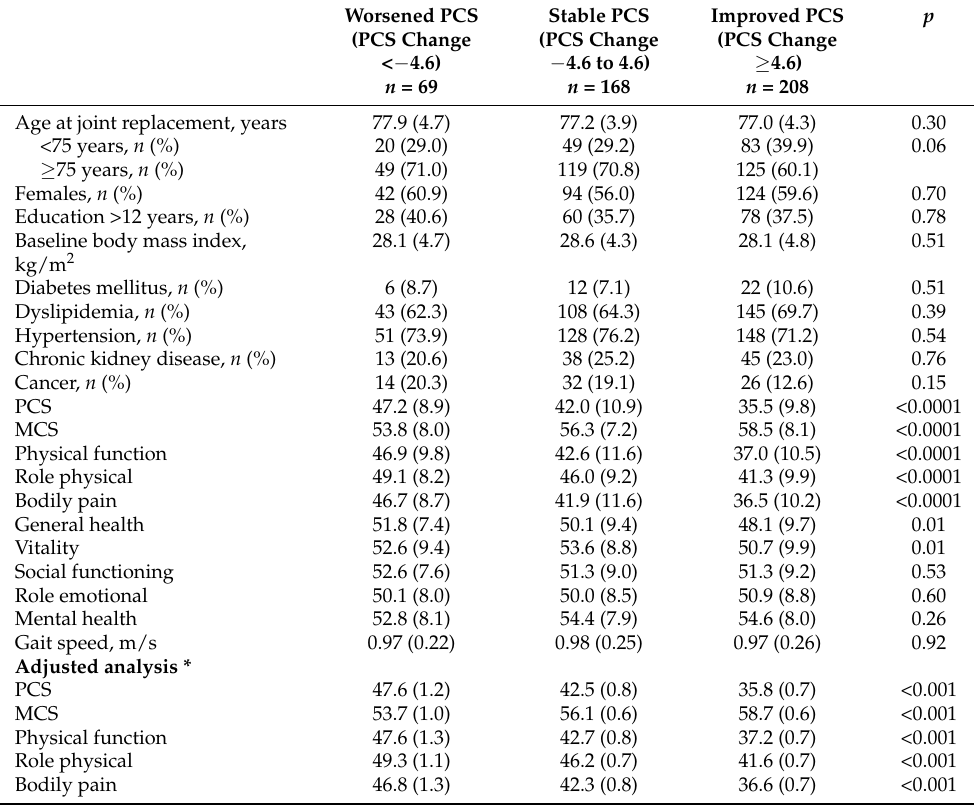
Table 3. Baseline characteristics of participants with hip replacement based on minimal important change in self-reported physical